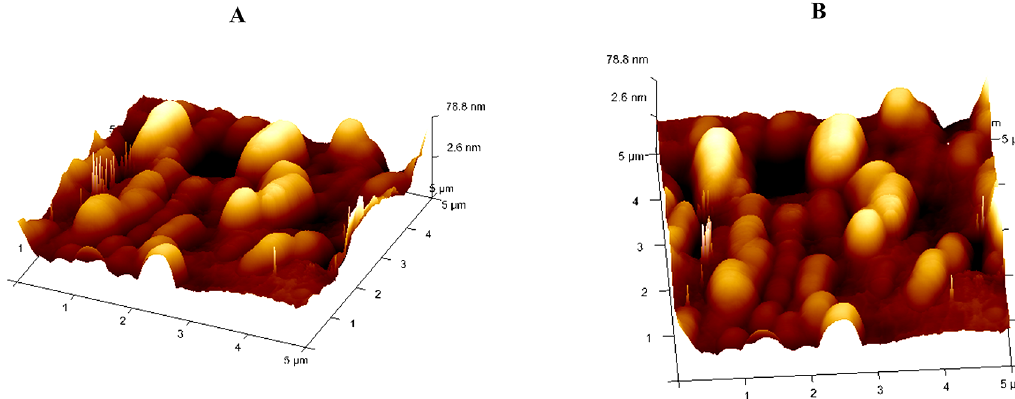
Figure 5. AFM of CLCAE and